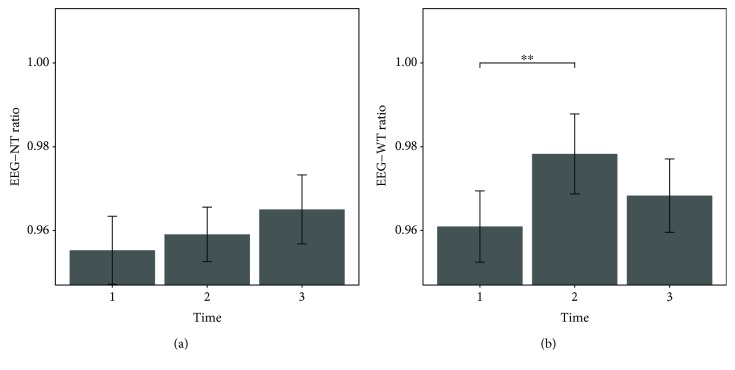
Barplots showing the alpha/delta power ratio over the four electrodes used for training in measurements before (t1), 1 week after (t2), and 3 months after (t3) the neurofeedback intervention. Error bars represent ±1 standard error for within-subject designs according to Morey [60]. The alpha/delta ratio of EEG-NT (a) did not vary significantly over time. The ratio of EEG-WT (b) increased significantly over the course of the training, between t1 and t2, followed by a nonsignificant decrease to t3.